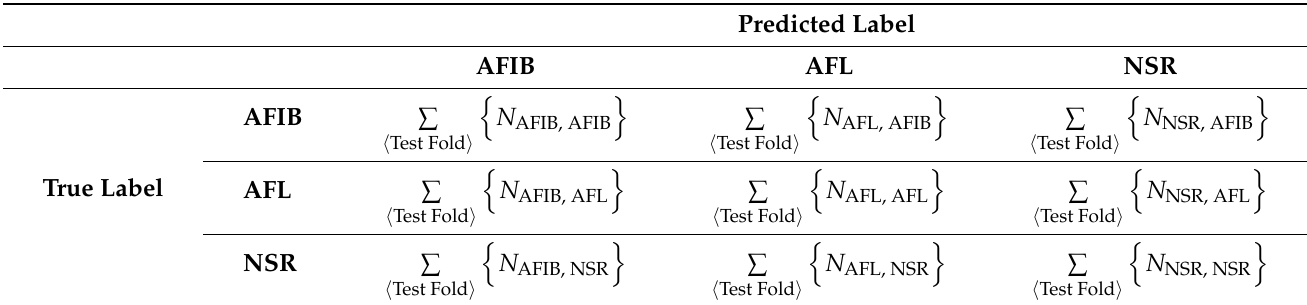
Table 7. The average cross-validation confusion matrix. ∑